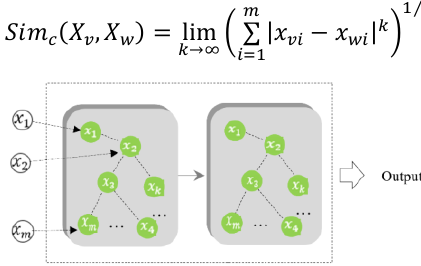
Fig. 1. GCN network